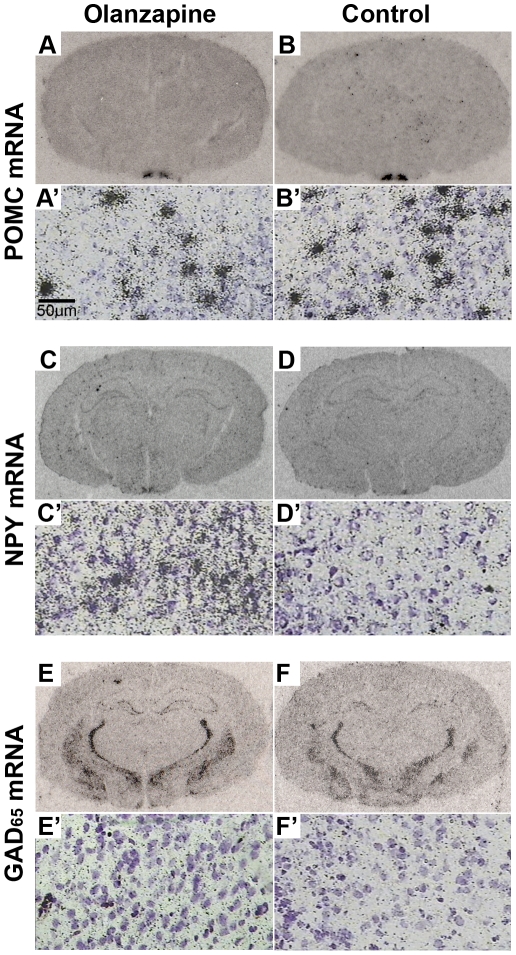
Examples of POMC, NPY and GAD65 mRNA Expression Following Olanzapine Treatment.Examples of pro-opiomelanocortin (POMC), neuropeptide Y (NPY) and glutamic acid decarboxylase 65 (GAD65) mRNA expression in the female Sprague Dawley rat brain following 2.0 mg/kg olanzapine treatment (A-A′, C-C′, E-E′) or vehicle (control) (B-B′, D-D′, F-F′) for 14-days (t.i.d.). (A–F): Low magnification film autoradiographs depicting mRNA expression in the rat brain, (A′–F′): High magnification emulsion/cresyl violet–stained slides showing mRNA expression specifically in the arcuate nucleus. Autoradiographs are examples of raw data used for the graphs depicted in Figure 3A–C and are average representations of 6 rats per treatment group.